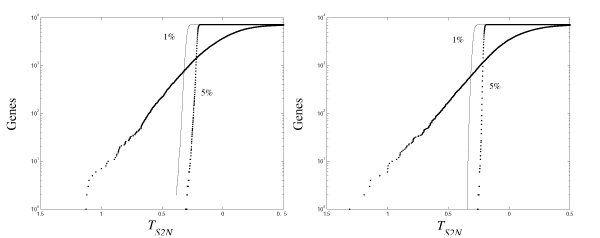
: Observed Ts2N(j) distribution computed on the Leukemia data set, compared to randomly permuted class distinctions. The number of genes highly expressed in a) ALL and b) AML is shown on y-axis.